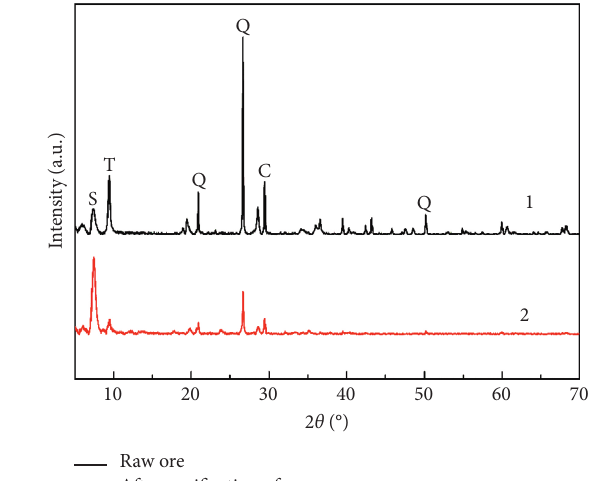
Figure 17: XRD phase analysis of sepiolite and purified sepiolite (1: raw ore; 2: purification of sepiolite; S: sepiolite; T: talc; Q; quartz; C: calcite).